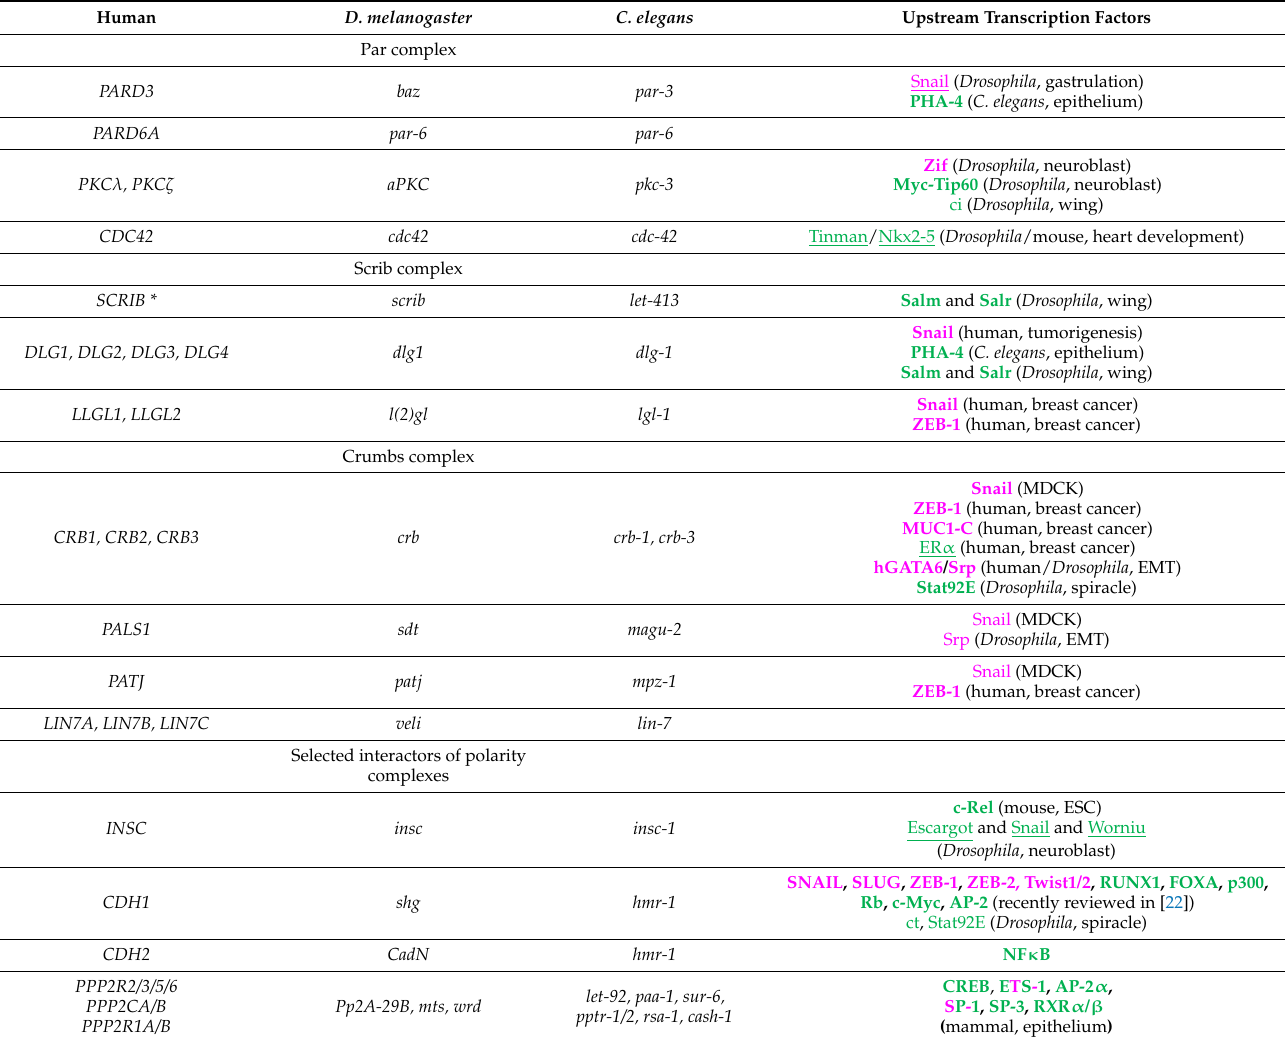
The table lists genes encoding cell polarity determinants and their orthologs in human, Drosophila melanogaster, and Caenorhabditis elegans . Upstream regulators are bold when they are known to directly affect transcription of their targets, underlined when they affect their target indirectly and in normal letters when the exact mechanism is unclear. Magenta text indicates repression, green text indicates activation of gene expression. * Two related proteins, ERBIN (enoded by ERBIN ) and LANO (encoded by LRRC1 ), act redundantly with SCRIB in mammals [23]. MDCK: Madin-Darby Canine Kidney